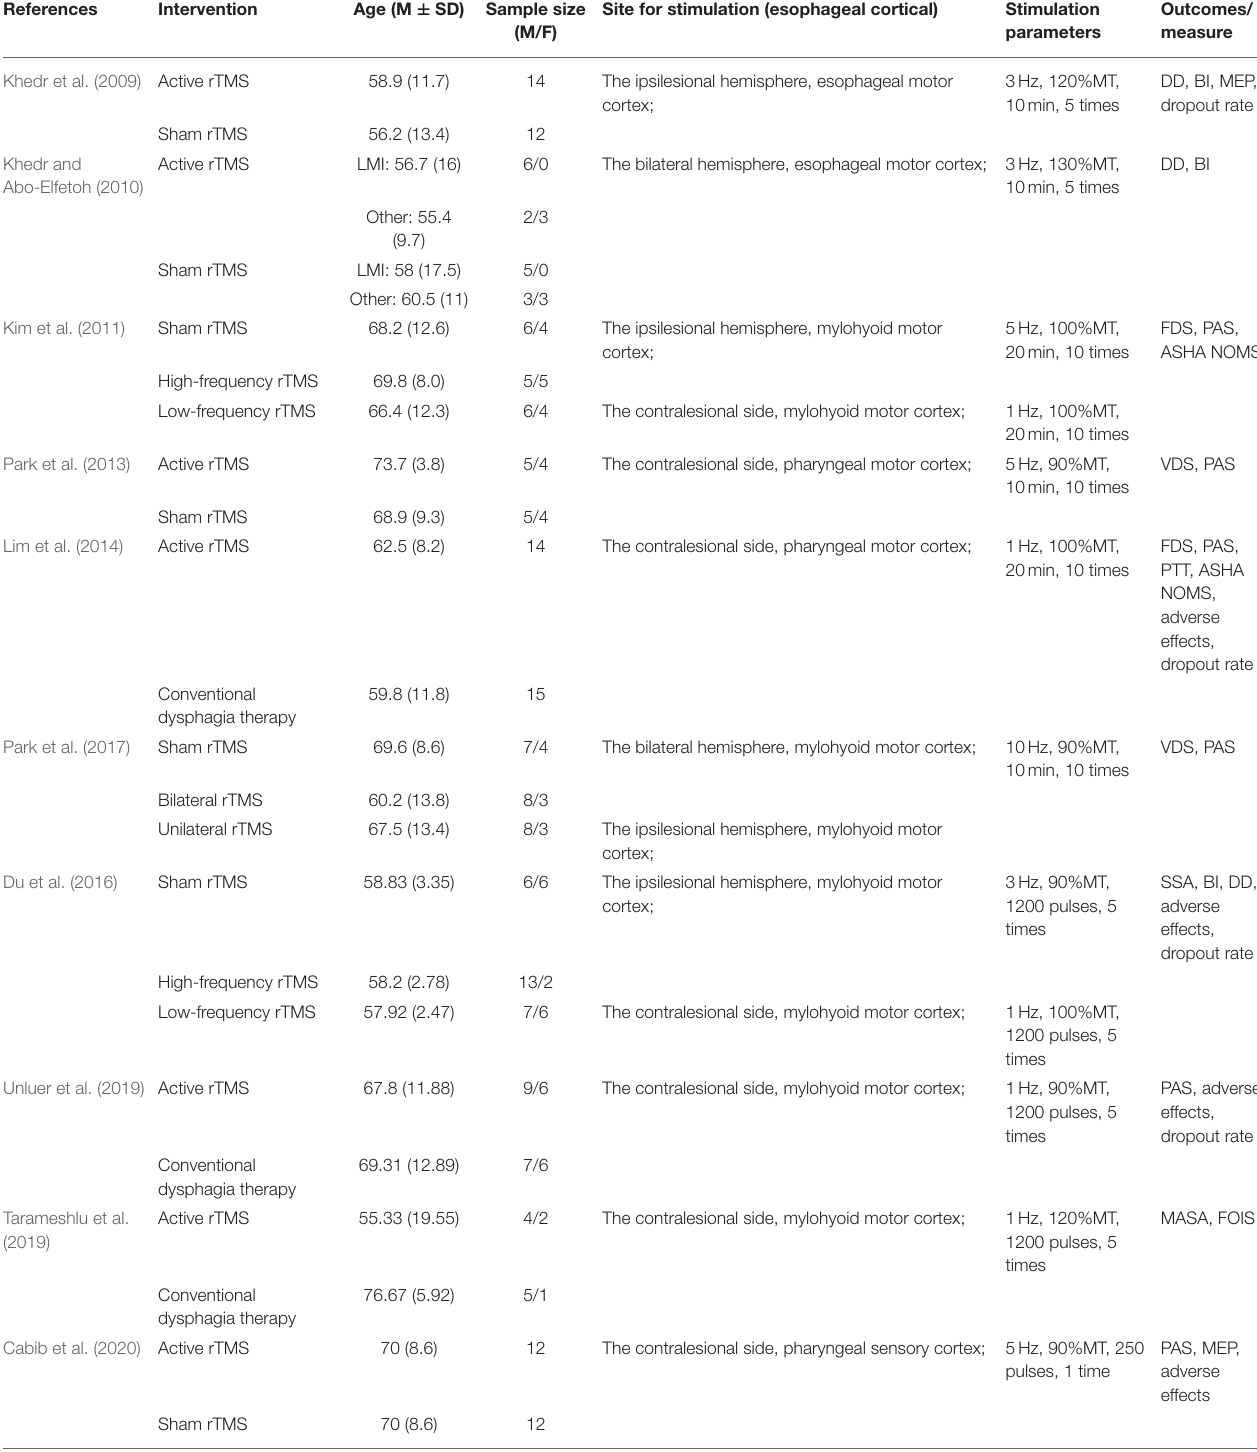
TABLE 1 | Characteristics of the randomized controlled